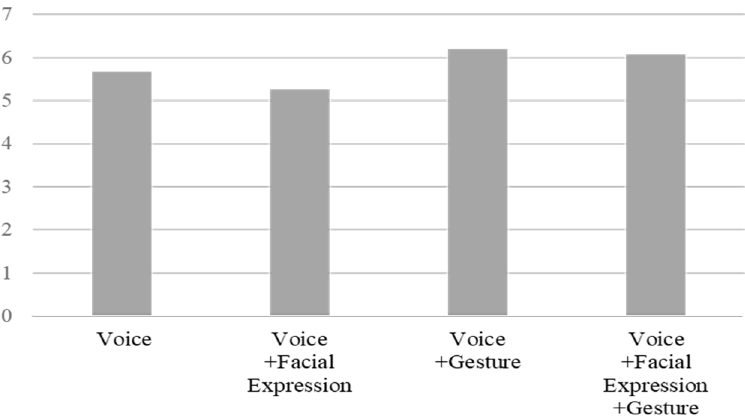
Figure 8. The degree to which the robot felt like a human by interaction type.